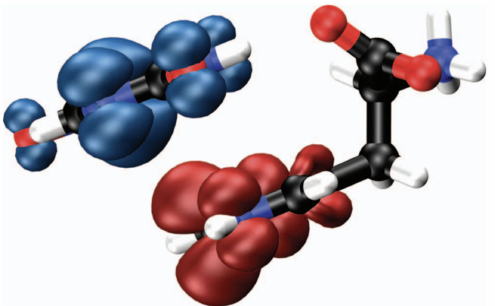
Figure 18. Difference density plot (isovalue 0.004) between ground and excited state (S1-S0) of L-His+5NU − obtained from a TD-DFT (X3LYP/6-311++G**) calculation. Blue indicates positive values and red negative values. Reprinted with permission from Ref. [54], 2012, AIP publishing.